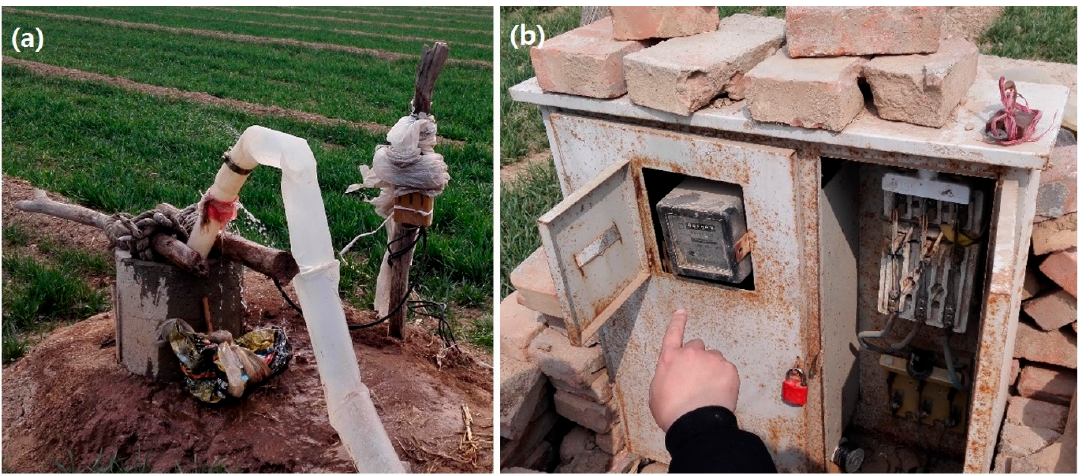
Figure 2. A typical well in Guantao County ( a ) and the electricity meter at the well ( b ). A rigid plastic pipe is attached to the submersible pump in the well, and a flexible plastic pipe is used to convey water from the well to the field. The electricity meter is protected by a box together with the power switch of the pump.